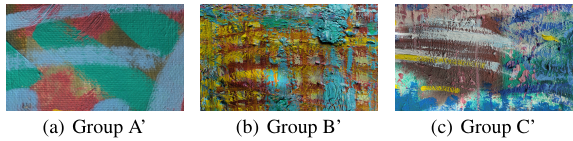
Figure 7. RTI data examples of three different groups.